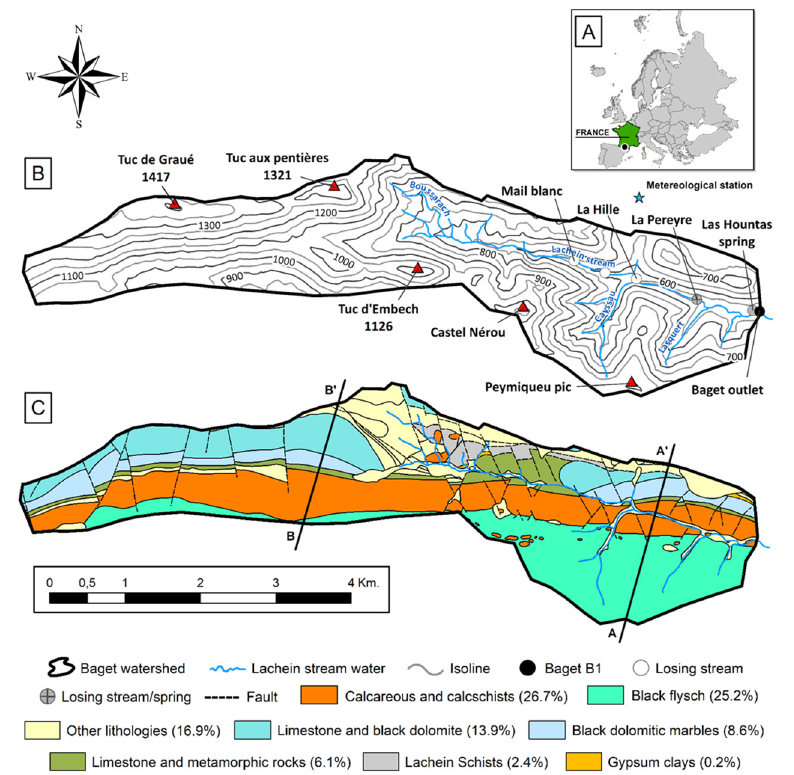
Figure 1. ( A ) Geographical location of the study area in the European map. ( B ) Relief map of the BC with contour lines (in meters). ( C ) Simplified lithological map of the BC with two geological